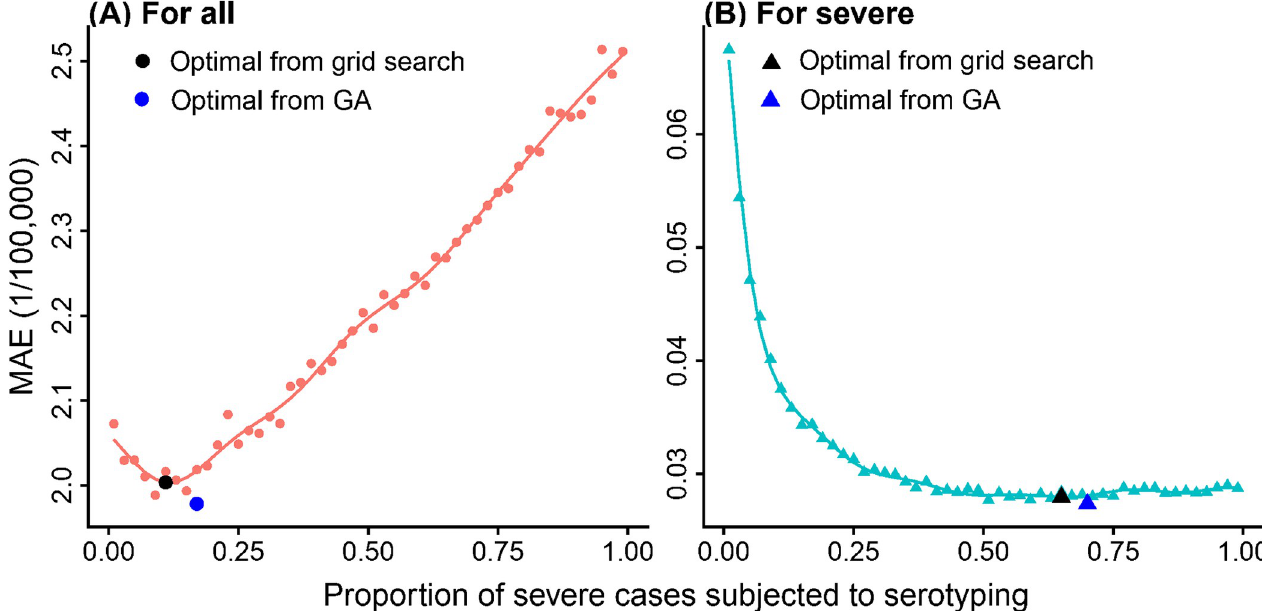
Fig 4. Impact of the proportion of severe cases serotyped on mean absolute error (MAE) of the estimated serotype-specific incidence rate of (A) all HFMD cases and (B) severe HFMD cases. Colored lines are smoothed by Gaussian process models. Black dot and triangle represent the probabilities of severe cases being serotyped that lead to the lowest error in estimating serotype-specific incidence rate of all (dot) and only severe (triangle) HFMD cases; blue dot and triangle represent the optimal designs from GA.